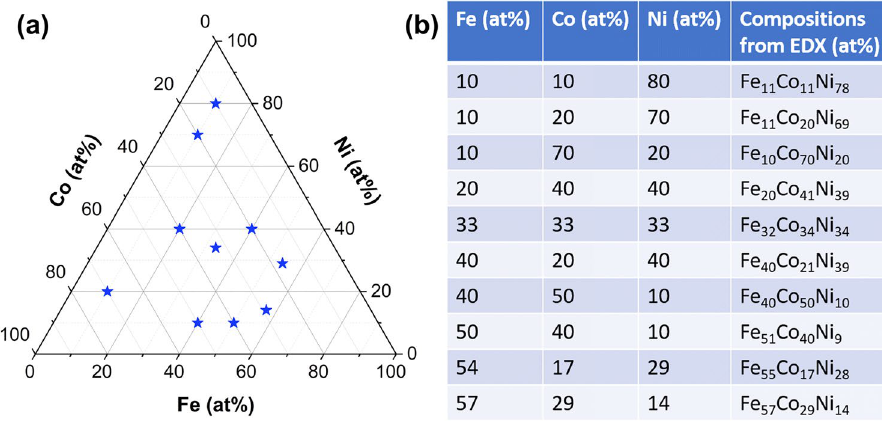
Figure 1. ( a ) Distribution of selected compositions shown on the ternary phase diagram, ( b ) Nominal and actual compositions of the Fe-Co–Ni ternary